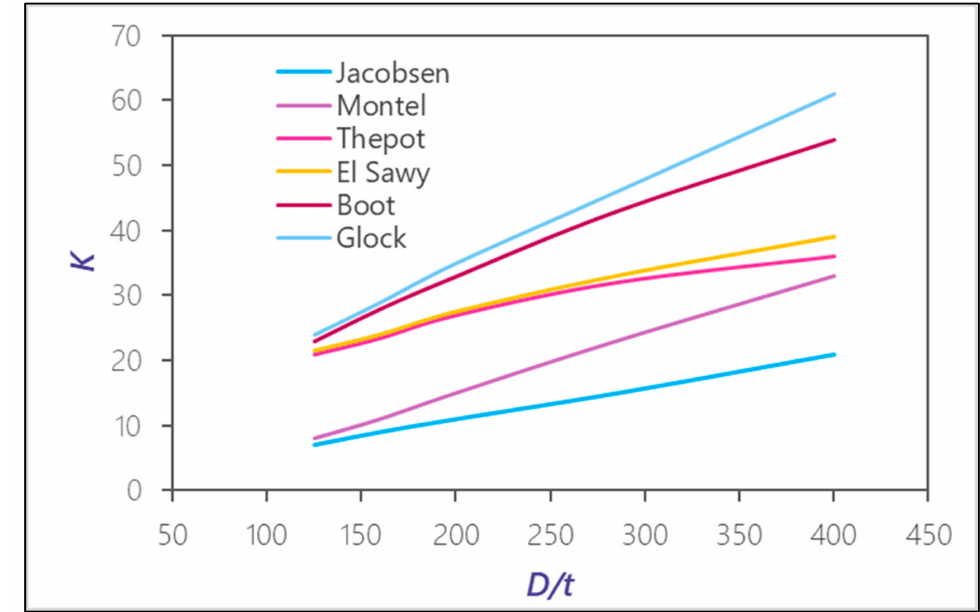
Figure 11. Parameter K with regard to Euler’s Pcr ideal ( g = 3